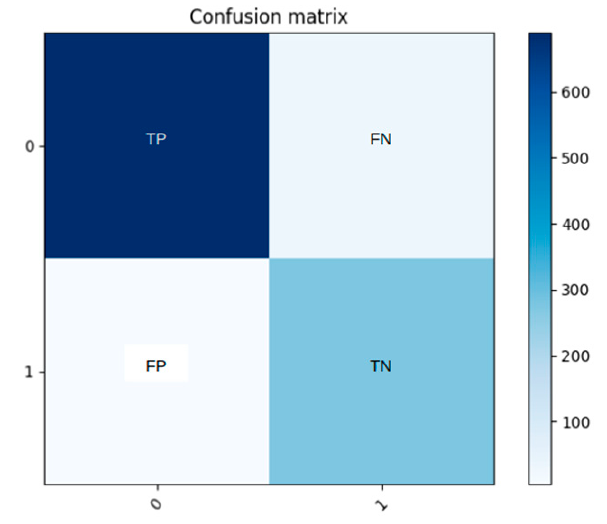
Figure 3. An illustration of Confusion Matrix.